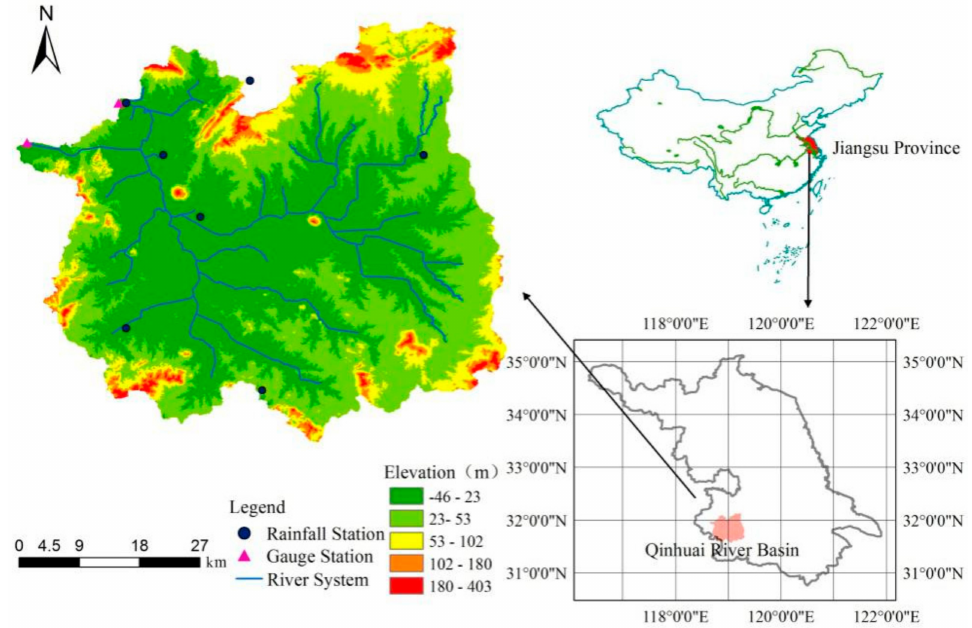
Figure 1. The location of the study area—the Qinhuai River